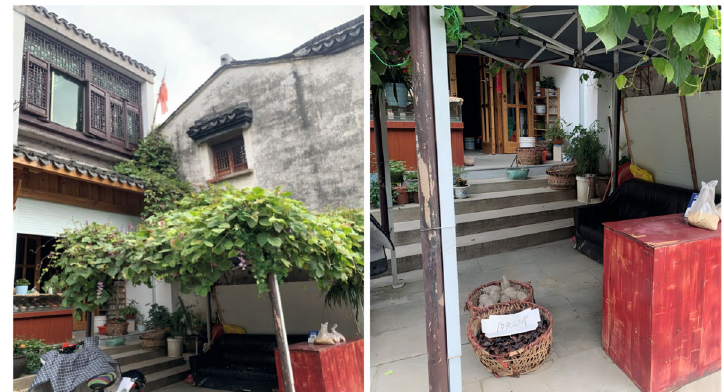
Fig. 11 Houses with local people (Source: the